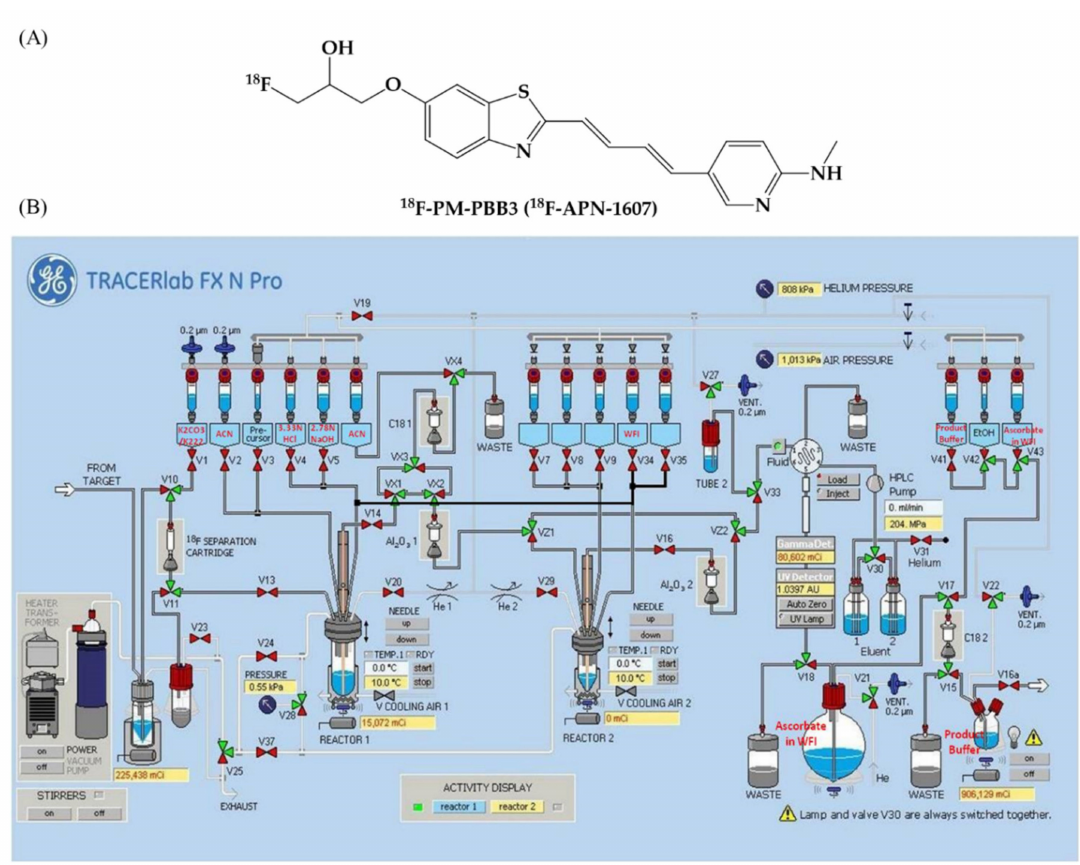
Figure 6. The chemical structure of 18 F-PM-PBB3 ( 18 F-APN-1607) ( A ) and its automatic radiosynthesis procedure scheme ( B